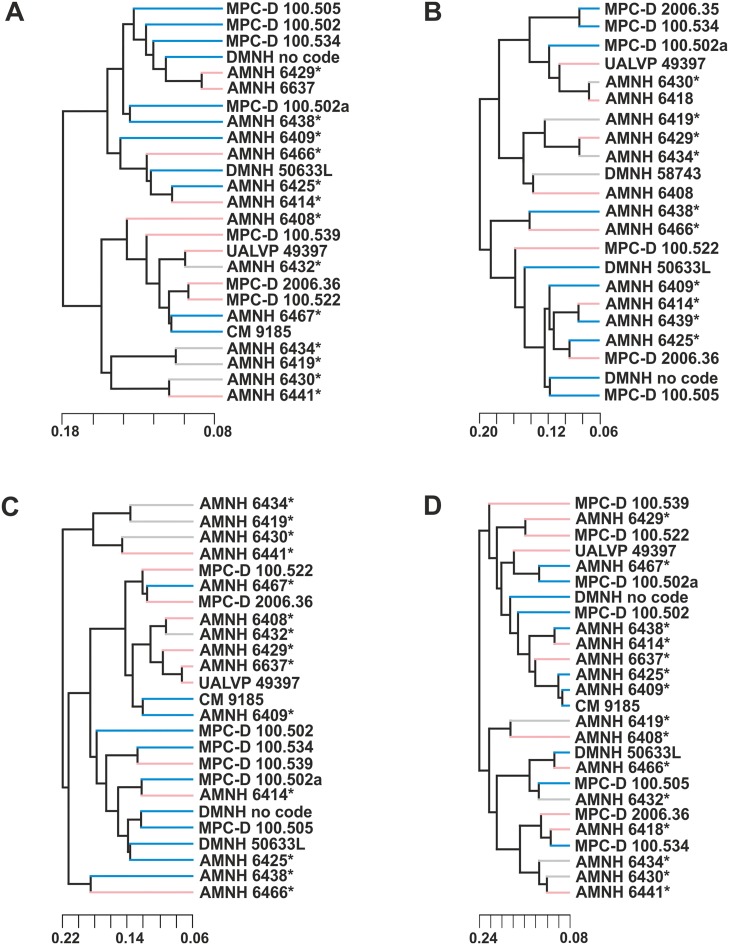
UPGMA cluster analysis performed on the four samples.A, UPGMA cluster analysis of skulls in lateral view. B, UPGMA cluster analysis performed on skulls in dorsal view. C, UPGMA cluster analysis of skulls without frill. D, UPGMA cluster analysis performed on the frills. Asterisks indicate specimens shared with Dodson [25]. Light blue indicates a “male”, pink indicates a “female”, grey indicates a juvenile.